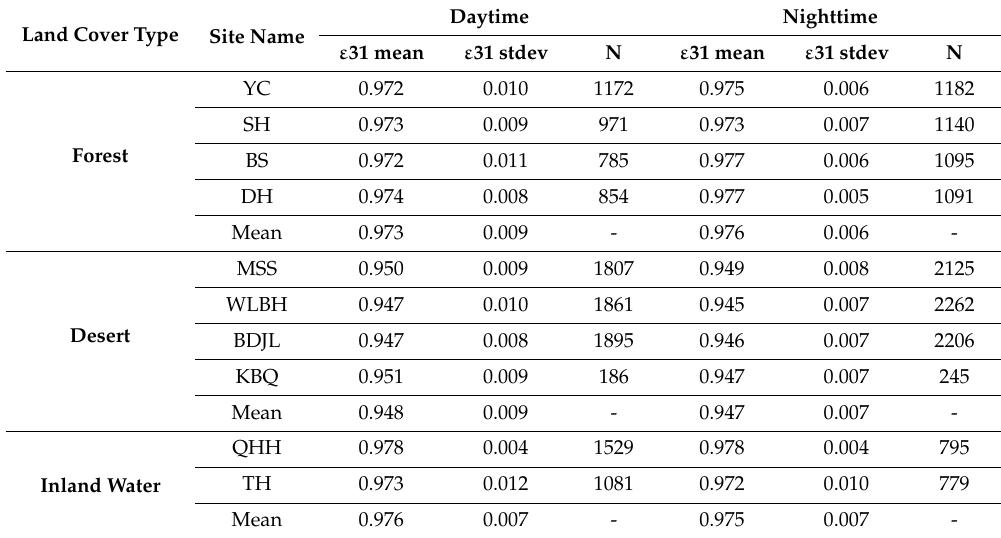
Table 7. The emissivity statistics for the R-based sites within 3 × 3 MYD21 (band 31) pixels in 2016. Land Cover